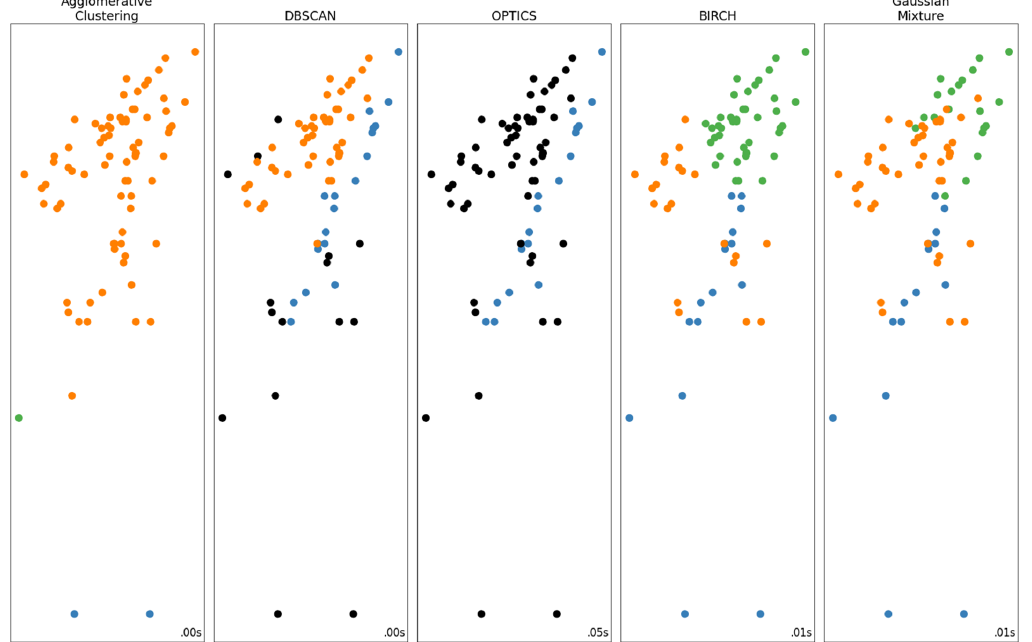
Figure A2. Attempt to partition the stage–discharge measurements of Sakoulevas River with the clustering methods: Agglomerative Clustering, DBSCAN, OPTICS, BIRCH, and Gaussian Mixture. Different colours indicate different classes. Black dots correspond to outliers. The x -axis is the discharge, the y -axis is the